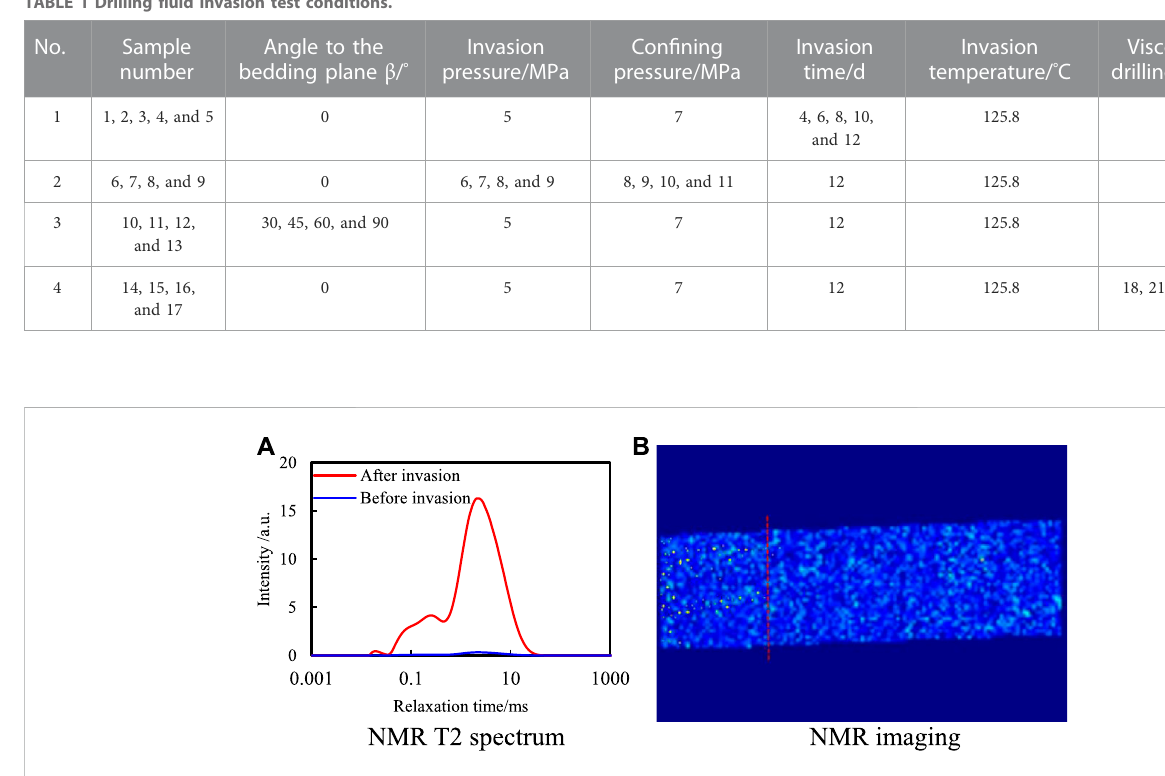
FIGURE 4 NMR spectrum. (A) NMR T2 spectrum. (B) NMR imaging.